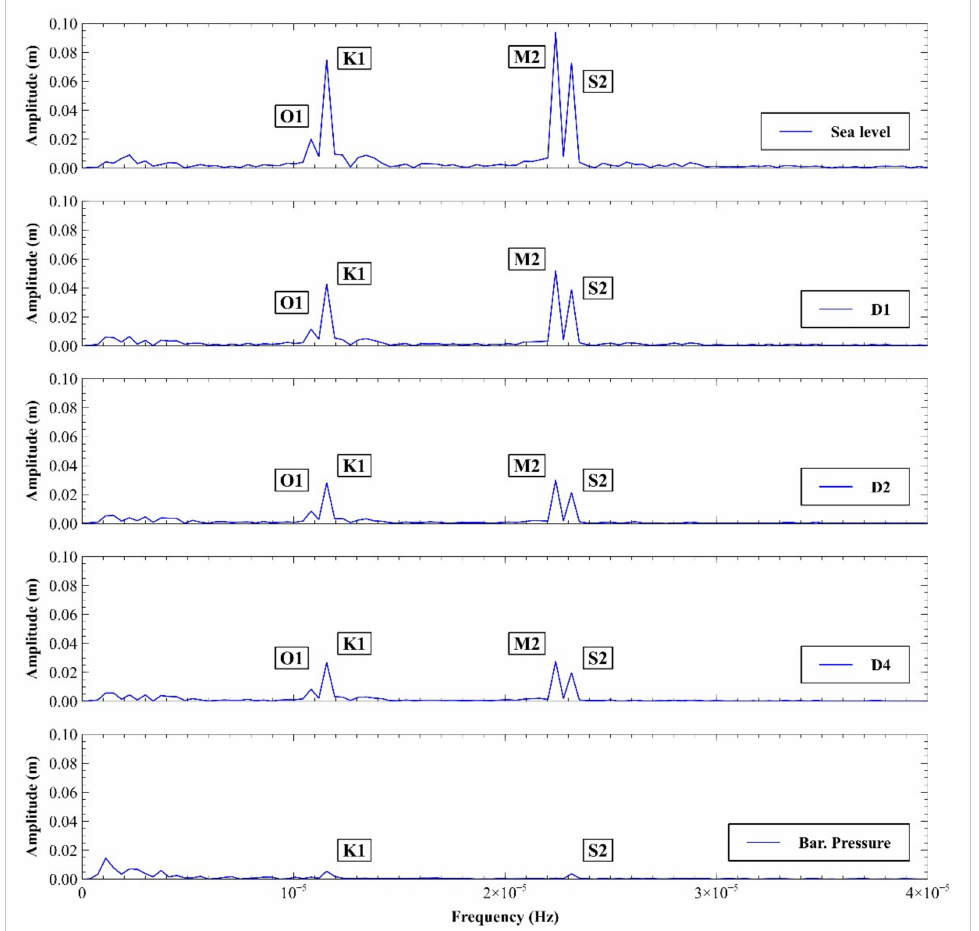
Figure 5. Sea level; D1, D2, and D4 piezometric head detrended and scaled signals; and detrended barometric pressure amplitude spectrum determined from the data series corresponding to the period of 1 August to 31 August 2015. M2: principal lunar semidiurnal constituent, S2: principal solar semidiurnal constituent, O1: lunar diurnal constituent, K1: lunisolar diurnal